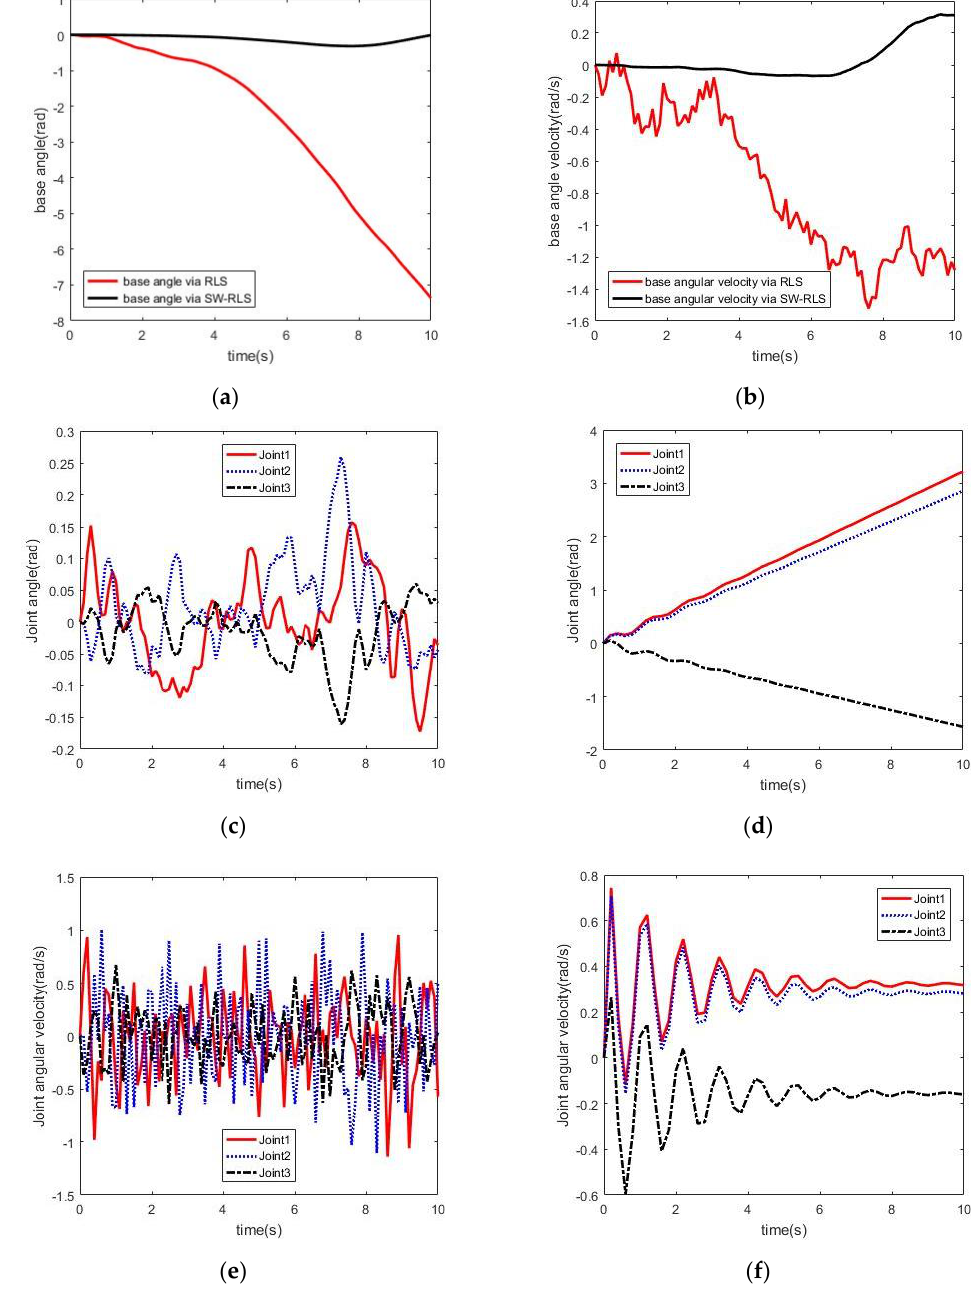
Figure 10. Space robot attitude parameters by experiment. ( a ) The base angle; ( b ) The base angular velocity; ( c ) The joints angle via Variable Forgetting Factor Recursive Least Squares (VFF–RLS); ( d ) The joints angle via RLS; ( e ) The joints angular velocity via VFF–RLS; ( f ) The joints angular velocity via RLS.